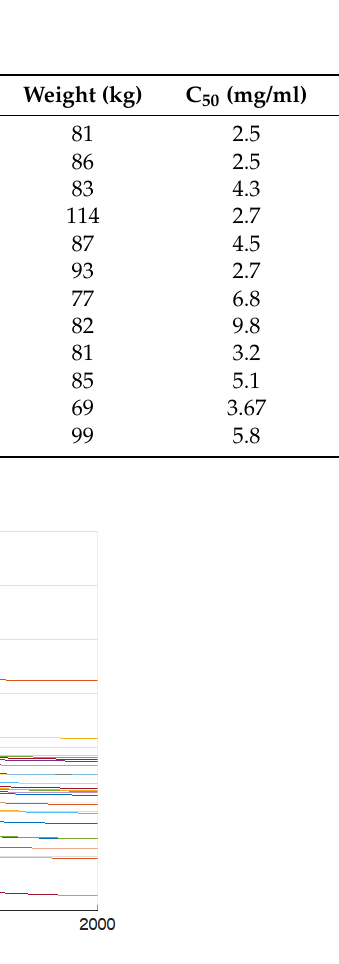
Figure 1. Open-loop analysis of BIS dynamics for 24 patients due to a step change in the propofol dose. Table 1. Representative Patient Database for Propofol-to-BIS with pharmacokinetic Model Bio- metric Values and PD Model Sensitivity Values [19].